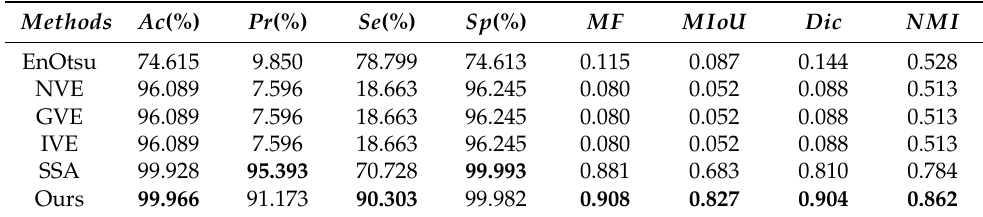
Table 1. Results on magnetic tile images in terms of Ac (%), Pr (%), Sp (%), Se (%), MF , MIoU , Dic , and NMI .